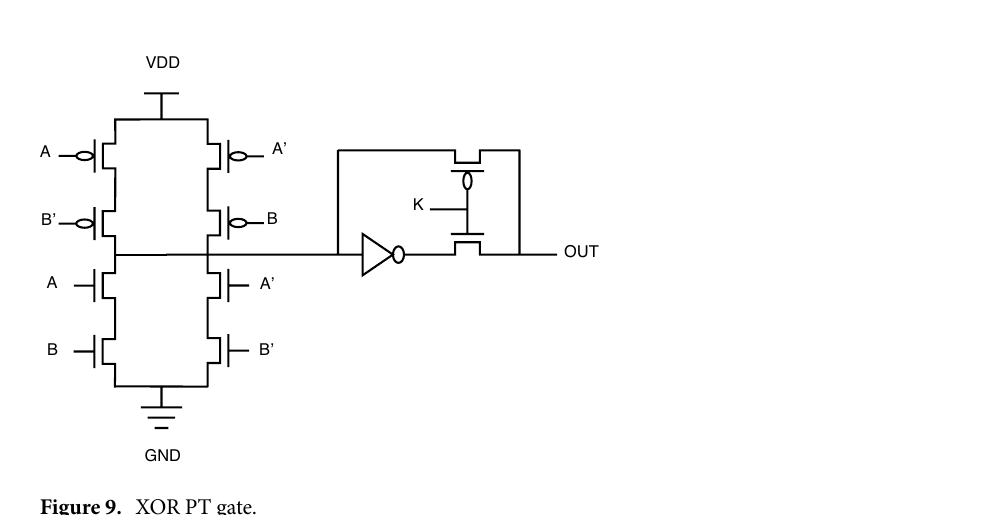
Figure 9. XOR PT